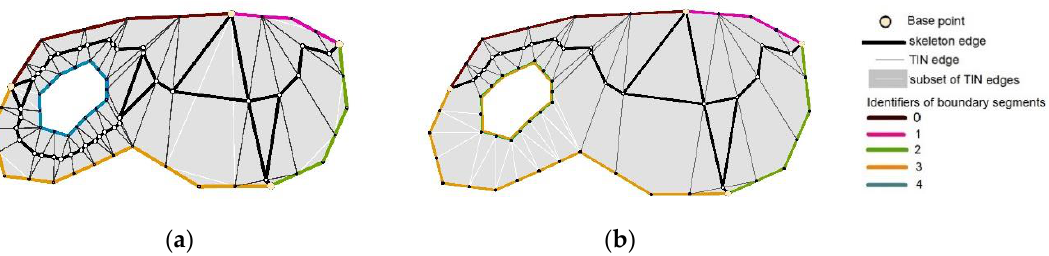
Figure 12. Skeletons generated for a polygon with a hole: ( a ) skeleton generated based on source data; ( b ) skeleton modified on the assumption that the skeleton should not be located south of the hole (the island ID was modified by changing the color of the island boundary).